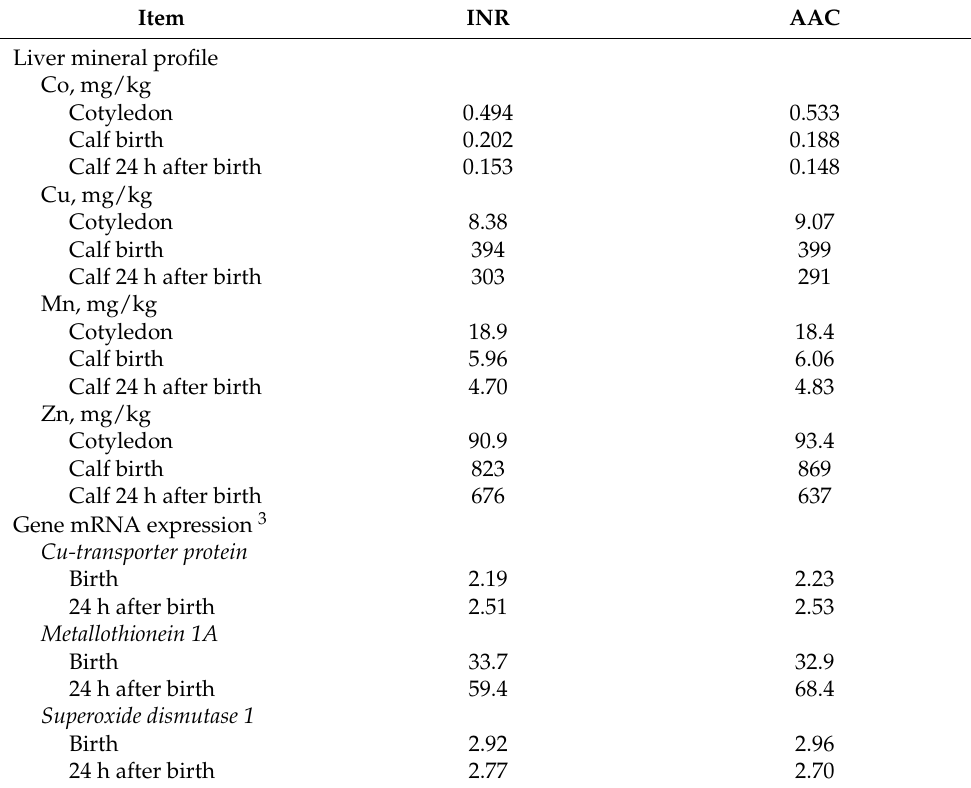
Table 3. Concentrations of Co, Cu, Mn, and Zn and expression of genes in the liver in beef cows that received diets containing supplemental sulfate sources of Co, Cu, Mn, and Zn (INR) or organic- complexed source of Co, Cu, Mn, and Zn (AAC) during gestation 1,2 . Item INR AAC Liver mineral profile Co, mg/kg Cotyledon 0.494 0.533 Calf birth 0.202 0.188 Calf 24 h after birth 0.153 0.148 Cu, mg/kg